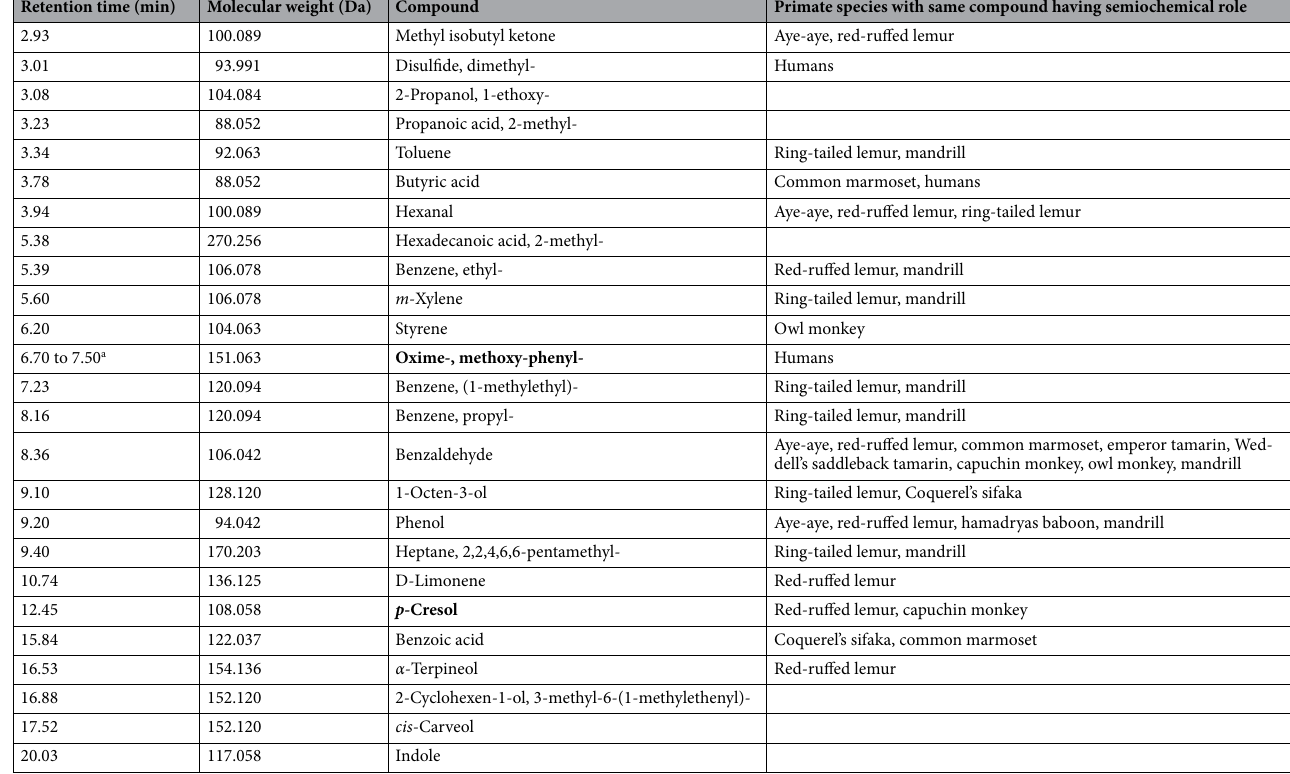
Table 2. Volatile compounds present in swab samples from baboon vaginal odour secretions identified tentatively using the ChemStation (Agilent Technologies) and NIST (version MSD F.01.01.2317) mass spectral databases, listed in order of retention time. The compounds in bold font were found with highest abundance and most change from sample to sample. a Peak overloading resulting in broad peak and RT